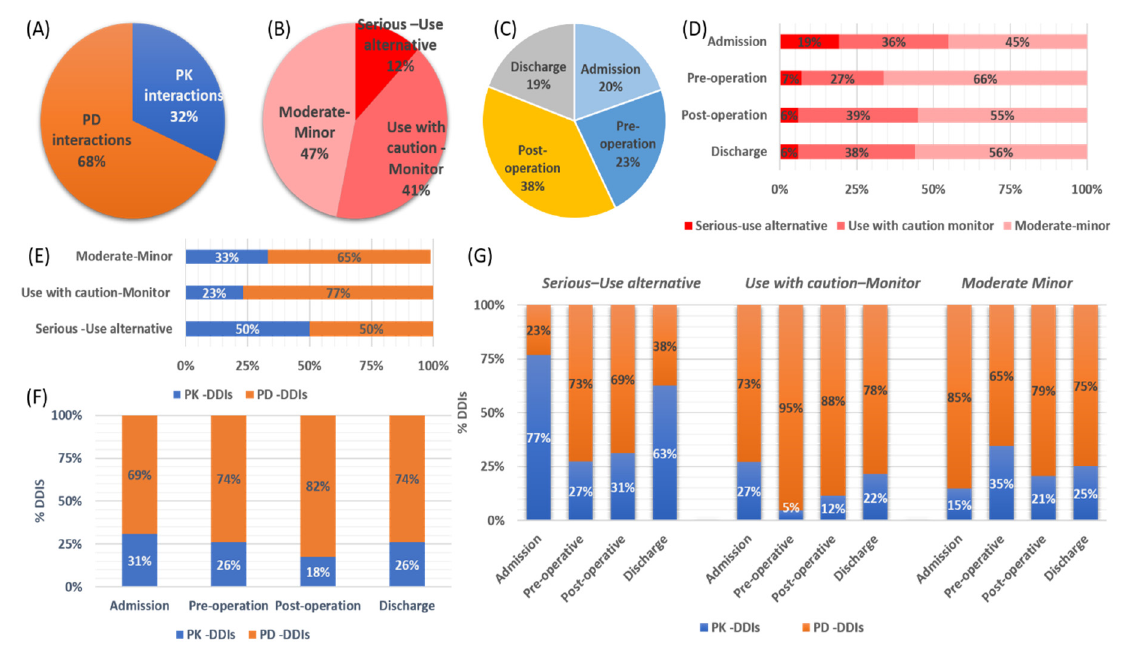
anti-inflammatory drugs; PPI: proton-pump inhibitor; ACE: angiotensin-converting enzyme inhibitor; ARB: angiotensin II receptor blockers; OATB1: organic anion transporter B1).